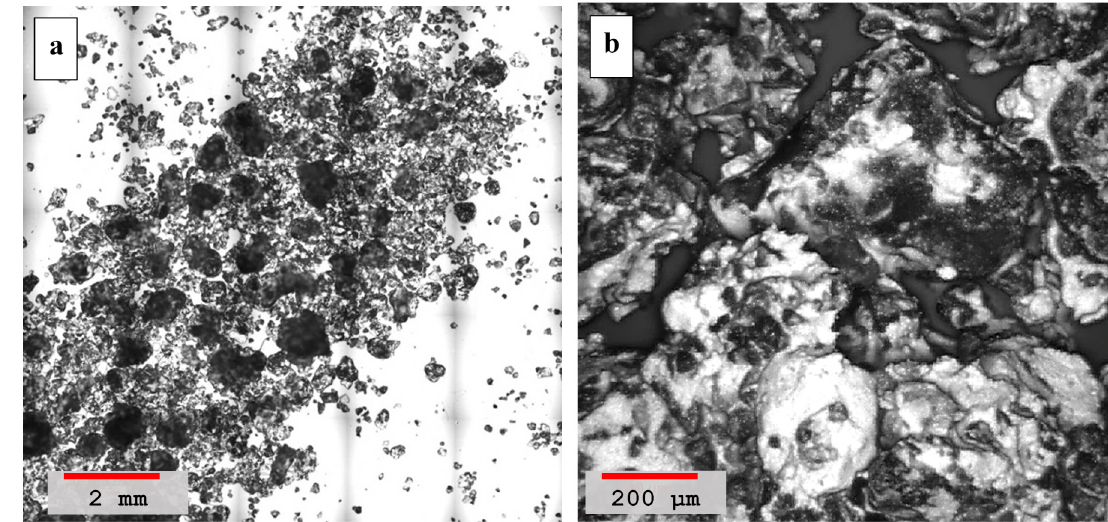
Figure 7. ( a ) Laser scanning microscopy image of hydrated mortar containing pure lime and sand, sample #b in Table 4, recorded at a lower 5× magnification image (red color scale-bar shows ≈ 2 mm length). ( b ) Morphological image of the sample at a higher magnification of 50× with a scale-bar showing ≈ 200 μ m length.